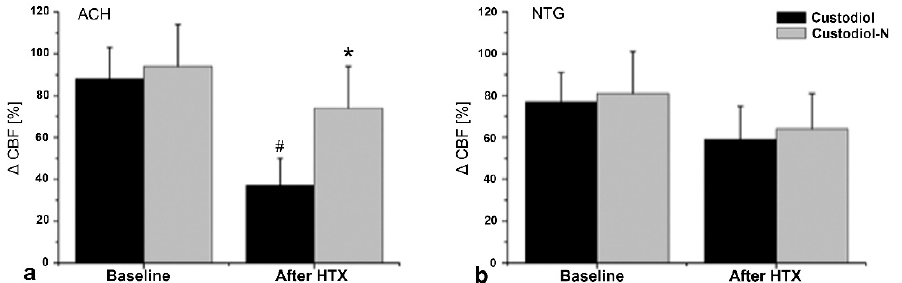
Figure 2. Coronary blood flow (Series 1: 4 h conservation time). Percentage change of coronary blood flow (CBF) after ( a ) acetylcholine (ACH) or ( b ) nitroglycerin (NTG). Mathematic formula: “((CBF + ACH or NTG)/(CBF before application of vasodilator))—1”. Values given as mean ± SEM. * p < 0.05 vs. corresponding control, # p < 0.05 vs. corresponding baseline. n = 8 in each experimental group.